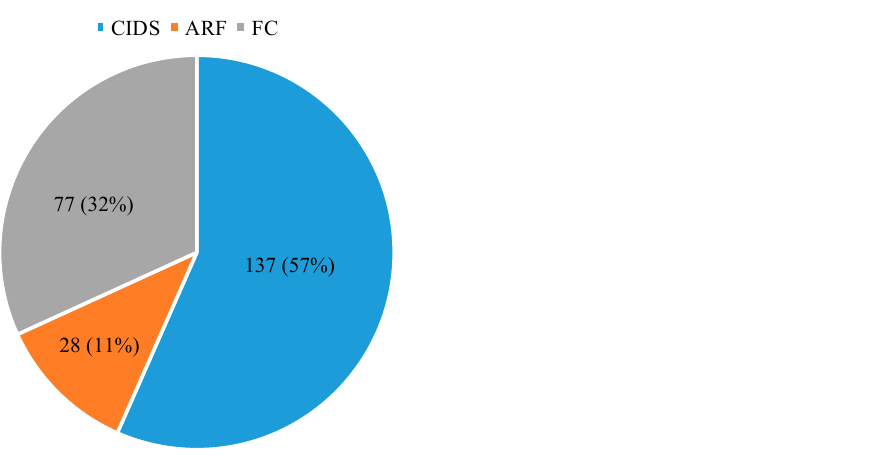
Figure 2. Number of occupied nests of Megachile cephalotes at three different sites from January to